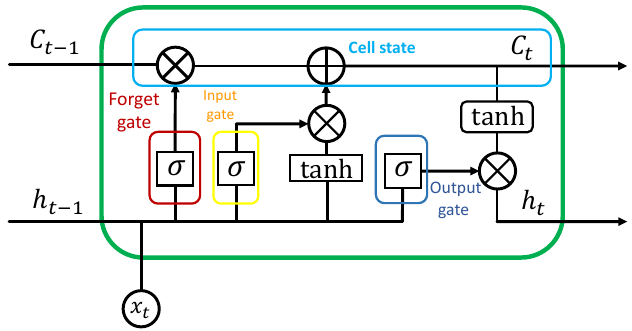
Figure 1. The memory cell and the gates of an LSTM memory